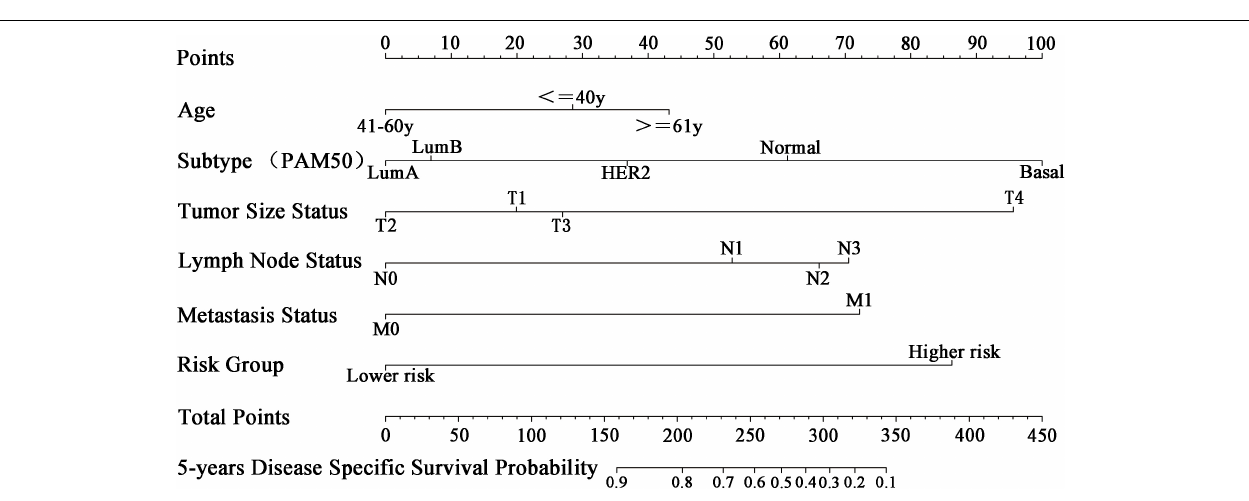
FIGURE 9 | Nomogram for predicting 5-year DSS of patients with BC. Each clinical predictive factor corresponds to a designated point shown by a line drawn perpendicular to the point’s axis. The corresponding sum of risk factor points, shown as total points, can be used to estimate the probability of 5-year DSS by drawing a line straight down to the 5-year DSS